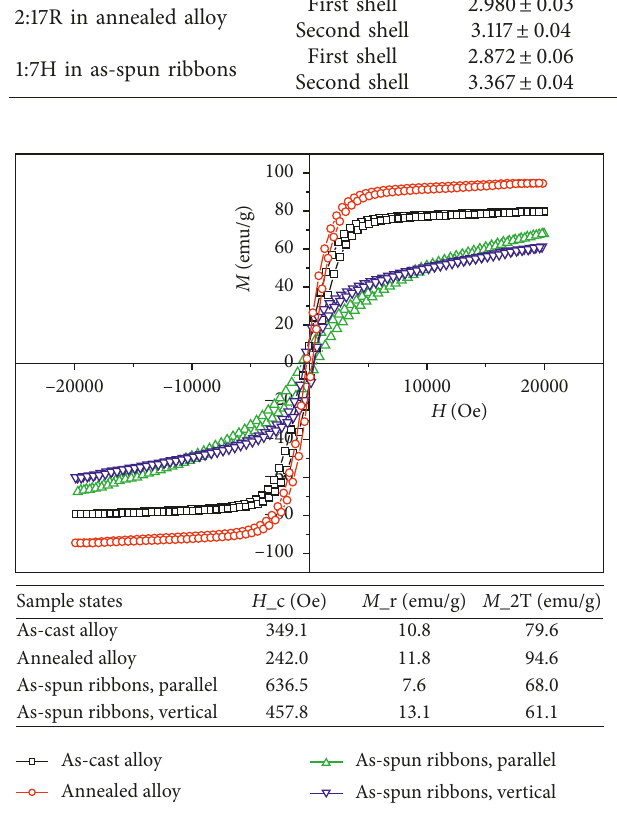
Figure 6: Hysteresis loops of SmCo